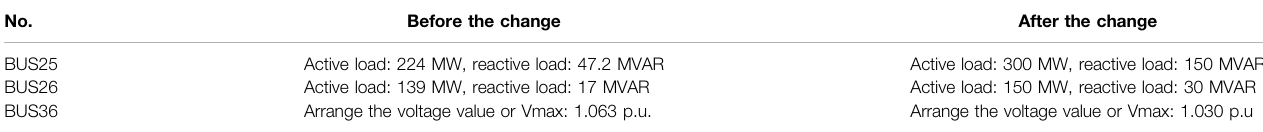
TABLE 2 | The modi fi ed parameters of the IEEE 39-node system. No. BUS25